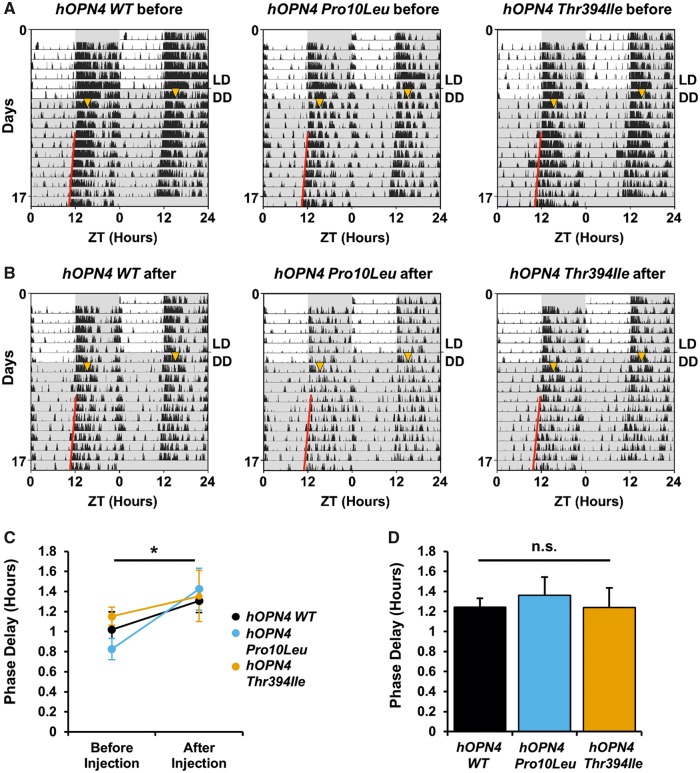
Phase delays are comparable between Opn4−/− Cre+/+ mice treated with either hOPN4 Pro10Leu, Thr394Ile or hOPN4 WT control AAV. (A, B) Representative actograms showing activity recorded by PIR detection from three Opn4−/− Cre+/+ mice tested (A) before and (B) after bilateral intraocular injection of hOPN4 WT (left), Pro10Leu (middle) and Thr394Ile (right) AAV. Animals were in 12: 12 LD cycle under white light (∼350 lux) for 6 days, then released into constant dark (DD) for up to 10 days. On the first day of DD animals were given a 15 min 100 lux white light pulse at ZT15 (shown as yellow triangle). Actograms are double plotted on a 24 h timescale. Grey shading indicates periods of darkness. Regression line (red) was used to calculate phase delay from onset of activity on first day of DD. Activity data are displayed in 1 min bins. (C) Increase in phase delay after injection is comparable between hOPN4 WT, Pro10Leu and Thr394Ile. n = 4–5 for each group test. * P < 0.05 main effect of injection, two-way mixed ANOVA. (D) Phase delays are similar in all three hOPN4 AAV conditions. n = 6–7 for each group, n.s. = not significant, one-way ANOVA. Data are shown ± S.E.M.